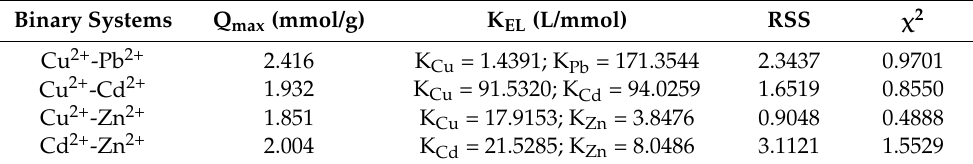
Table 4. Multi-component isotherm model parameters for the adsorption of Cu 2+ , Pb 2+ , Zn 2+ and Cd 2+ at 303